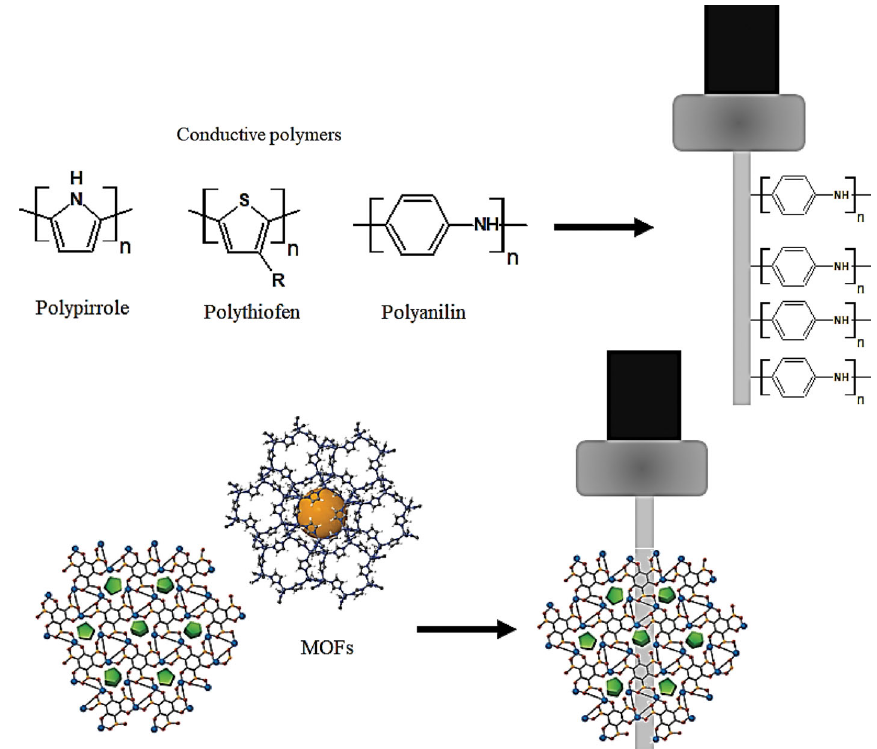
Figure 5: Schematic representation of SPME fibers coated with conductive polymers and